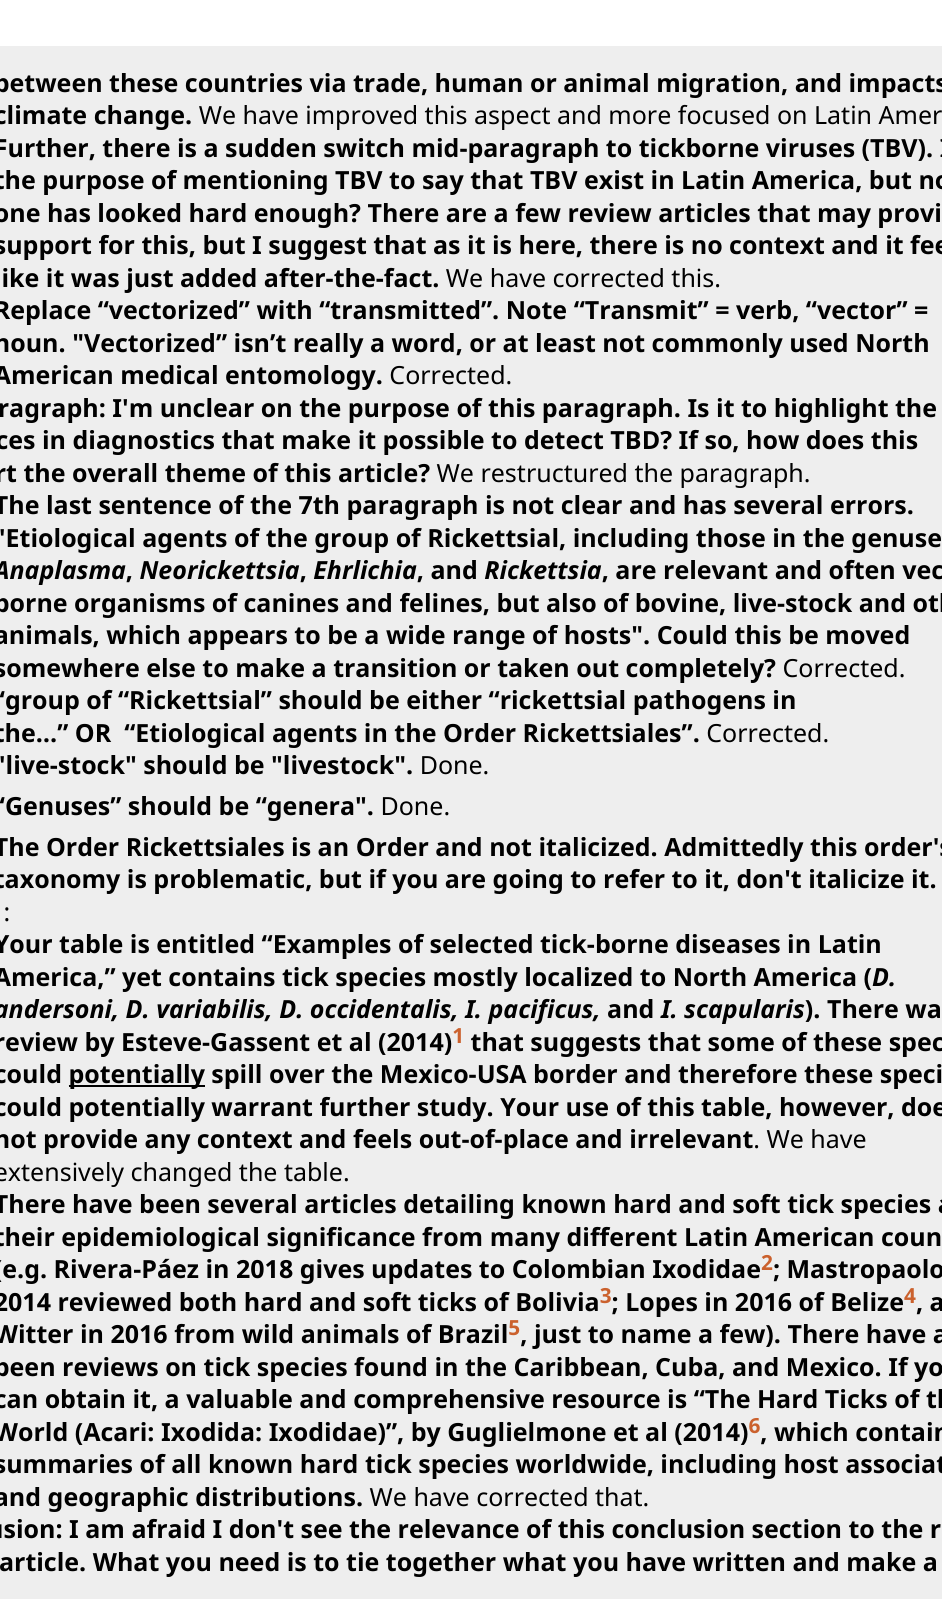
Your table is entitled “Examples of selected tick-borne diseases in Latin America,” yet contains tick species mostly localized to North America (